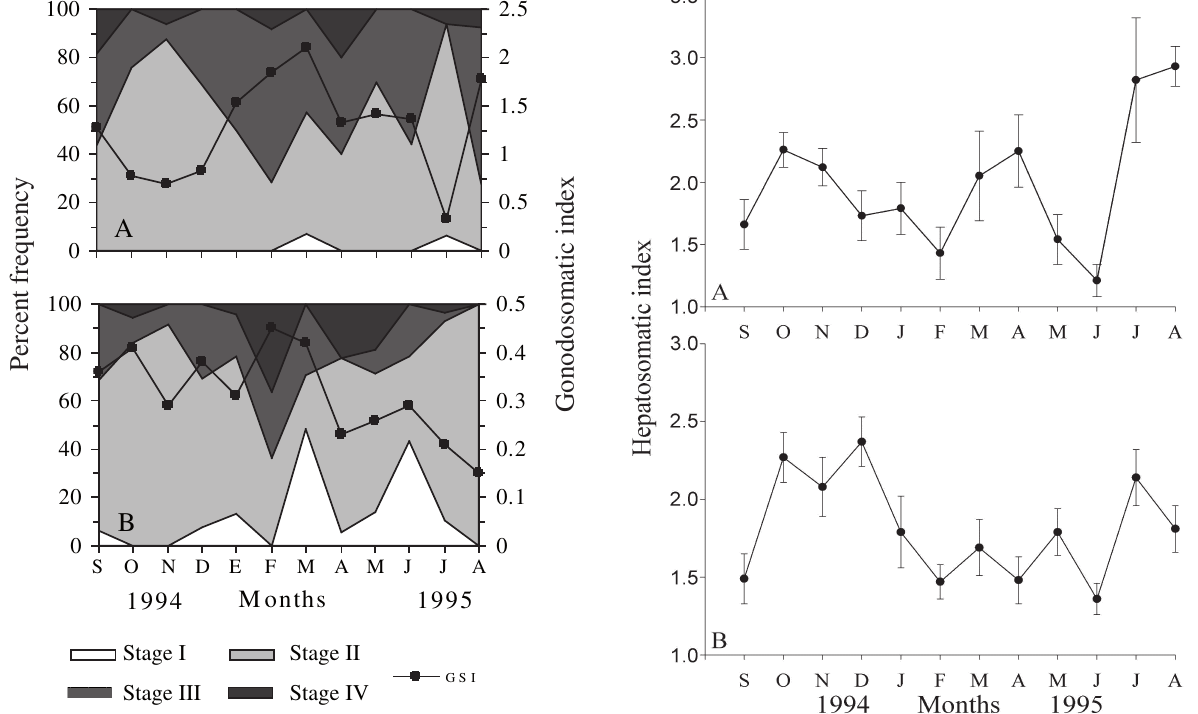
F IG . 3. – Monthly changes in GSI and in the frequency of occur- rence of the various maturity stages of gonads for female (A) and